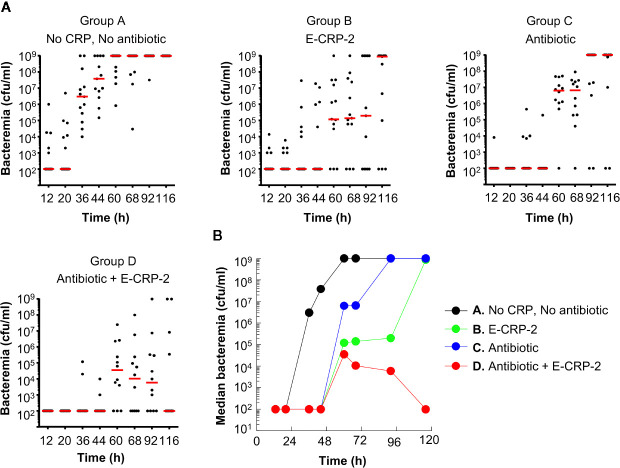
Bacteremia in mice infected with pneumococci and treated with E-CRP-2 and clarithromycin. Blood was collected from each surviving mouse shown in
Figure 4
. (A) Scatter plots of the bacteremia data. The horizontal red line in each group of mice represents median bacteremia. (B) The median bacteremia values, derived from (A) For 36–116 h, the p-value for the difference between groups A and B was <0.005. The p-values for the difference between groups A and C was <0.005 and <0.05 for 44–68 h and 92–116 h, respectively. For all time points, the p-values for the differences between groups B C and B D were >0.05. For 60 to 116 h, the p-value for the difference between groups C and D was <0.05.